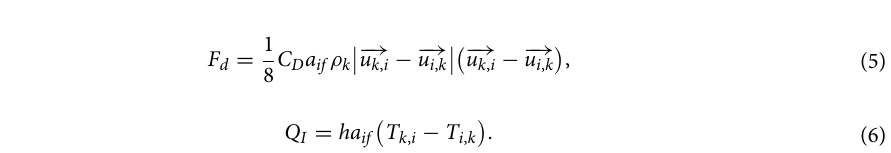
Figure 1. Validation of present CFD study versus Yu and Kim experiment and numerical investigation of Basha et